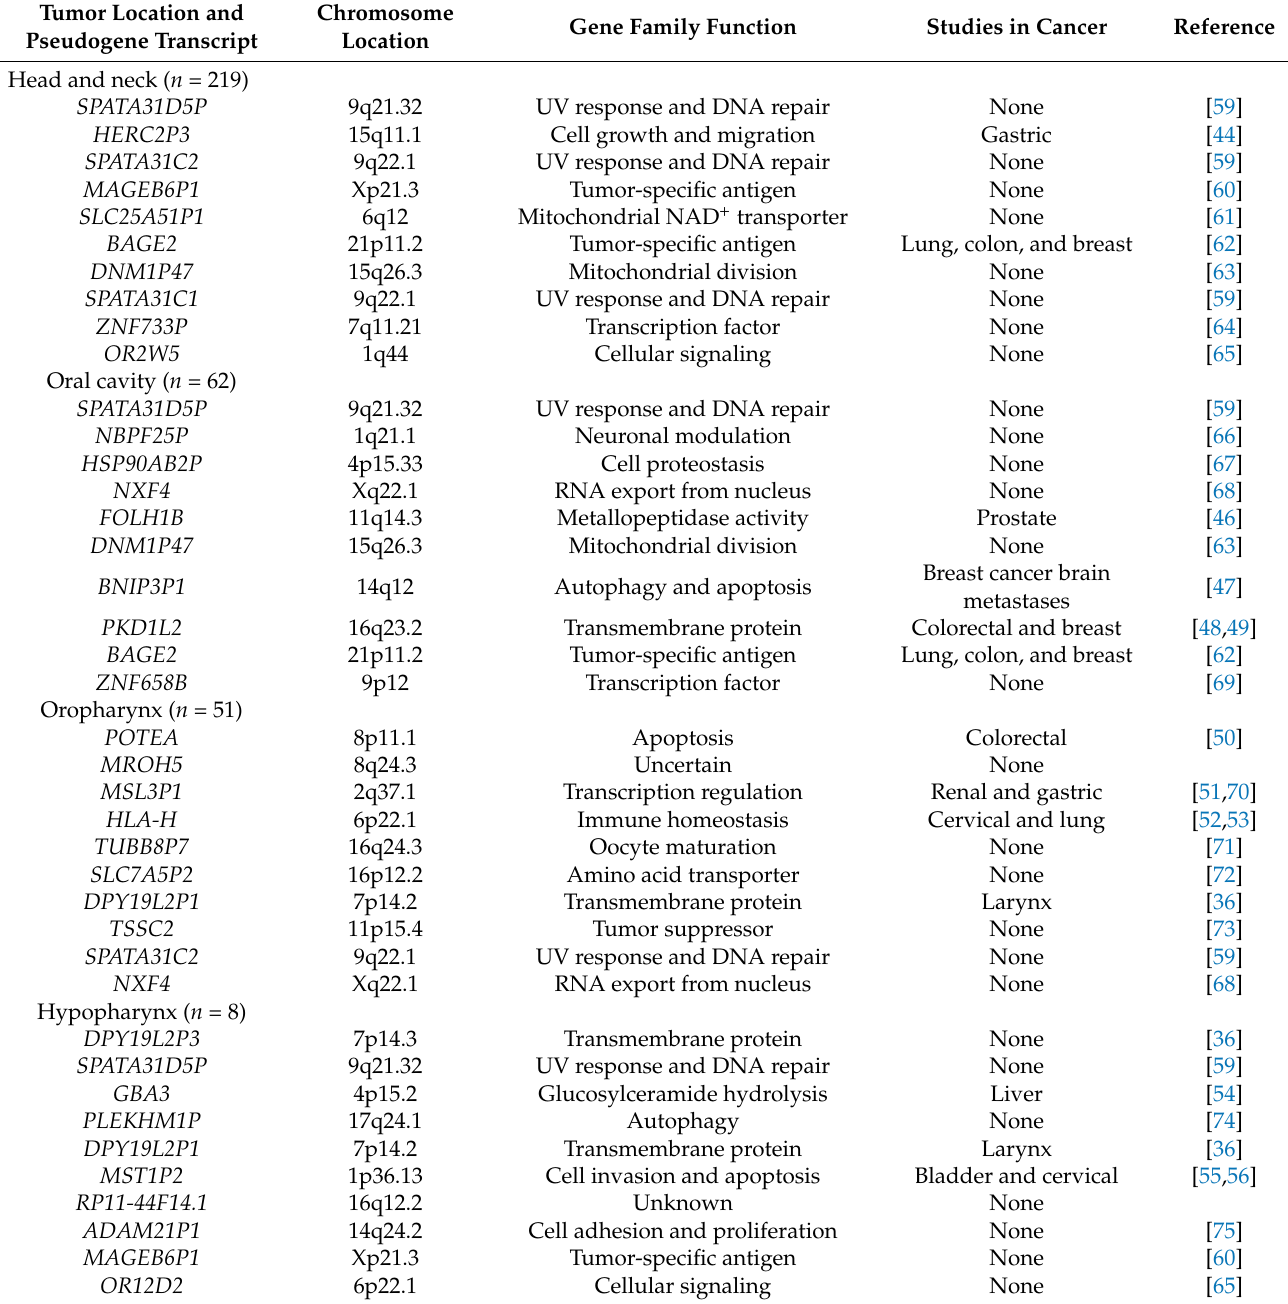
Table 2. Most deregulated pseudogene transcripts in head and neck cancer patients identified from The Cancer Genome Atlas (TCGA) database, chromosome location, gene family function, and studies in cancer. Tumor Location and Chromosome Gene Family Pseudogene Transcript